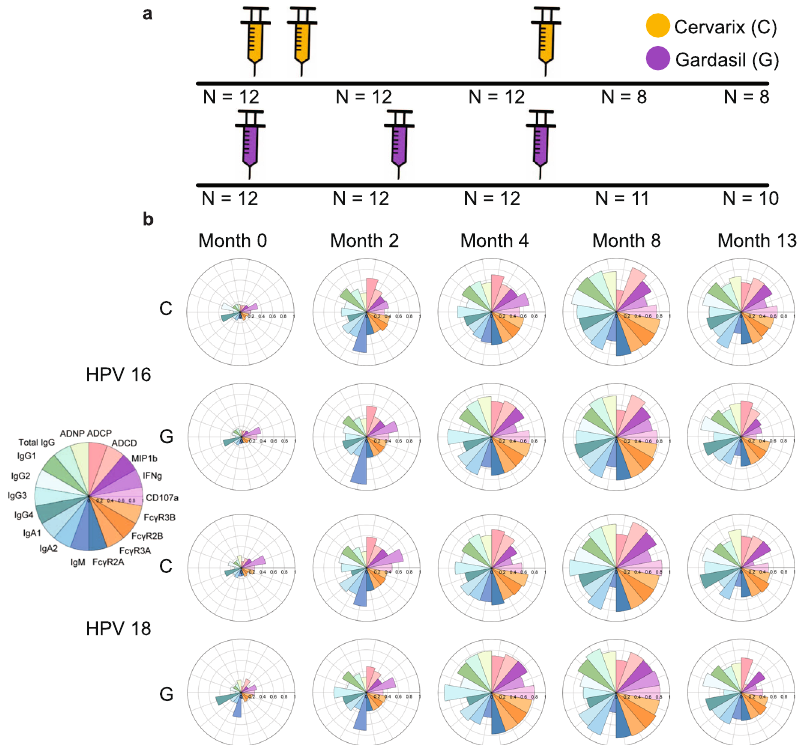
Fig. 1 Vaccination schedule and overall immune responses. a Injection schedule for Cervarix ® (orange) and Gardasil ® (purple). b The polar bar plots show the median percentile of antibody features induced by Cervarix ® (denoted by C) and Gardasil ® (denoted by G) against HPV16 (top) and HPV18 (bottom) across time points. The size of the wedges depicts the magnitude of the